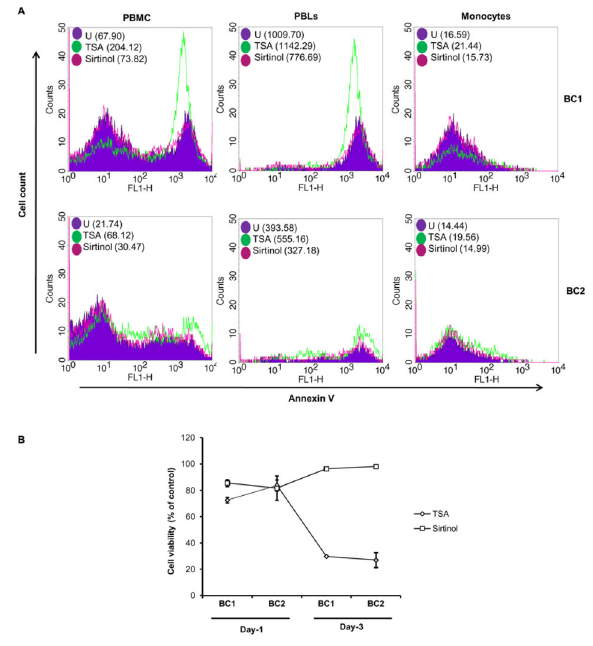
Figure 4. Effect of HDACi on cellular apoptosis and cell viability. A . Apoptosis of PBMCs, PBLs, and monocytes from healthy controls after treatment with TSA and Sirt. Apoptosis was measured by annexin-V assay as reported in the Materials and Methods chapter. Flow cytometric data at 72 h treatment are shown from two independent experiments. Mean fluorescence intensity (MFI) is indicated in brackets. BC, Buffy- coats of two healthy donors; PBLs: peripheral blood lymphocytes. B . Measurement of PBMC viability from healthy controls after one and three days of treatment with TSA and Sirt. Cell viability of PBMCs was determined by MTT assay after 24 h and 72 h treatment with TSA (1 microM) and sirtinol (10 microM). Data shown represent mean ± SD of triplicate wells.